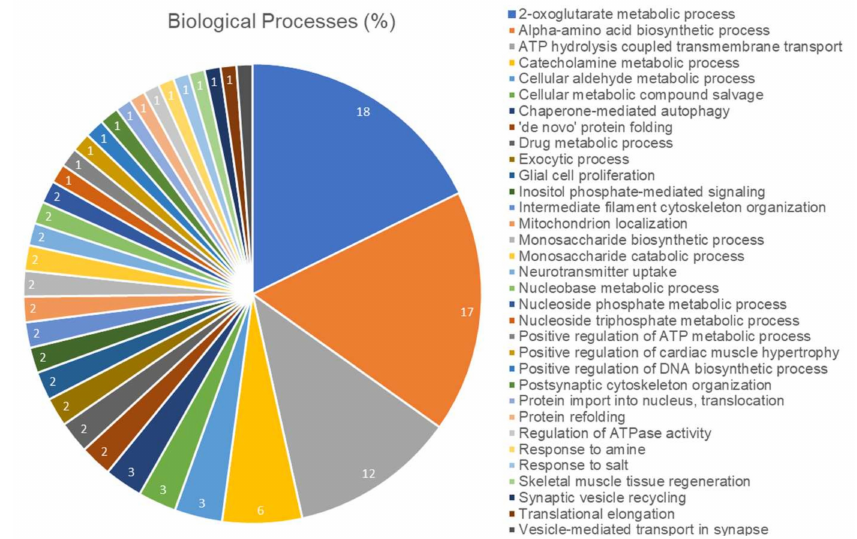
Figure 9. Functional distribution of proteins identified with di ff erential expression in cerebellum of rats exposed to Pb vs. control group. Categories of proteins based on Gene Ontology annotation of biological process. Terms significance (KappaScore = 0.4) and distribution according to percentage of number of genes. Proteins access number was provided by UNIPROT. The gene ontology was evaluated according to ClueGo ® plugin of Cytoscape ® software 3.6.1.